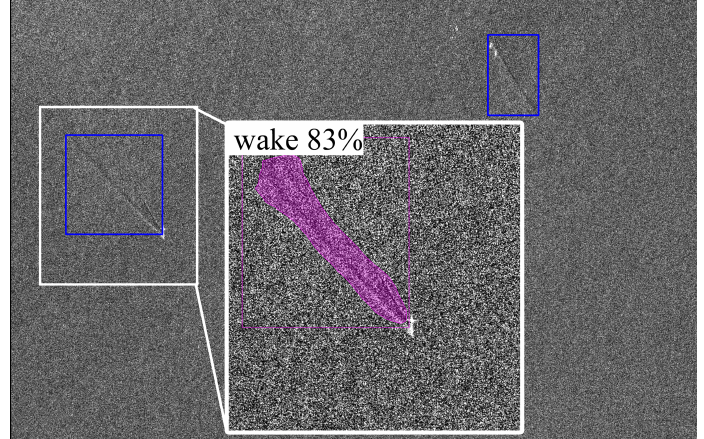
Figure 9. Detections over Scenario B (Azimuth-Ground Range coordinates).